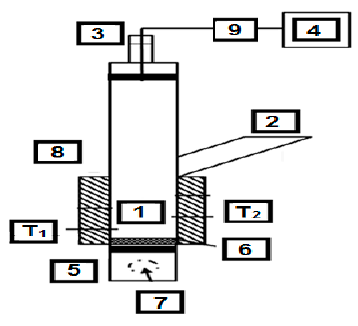
Figure 1. Research installation scheme. 1: process chamber, 2: fuel delivery, 3: gas outlet, 4: syngas analyzer, 5: air chamber, 6: grid, 7: air delivery, 8: thermal isolation, 9: cooler with heat, T 1